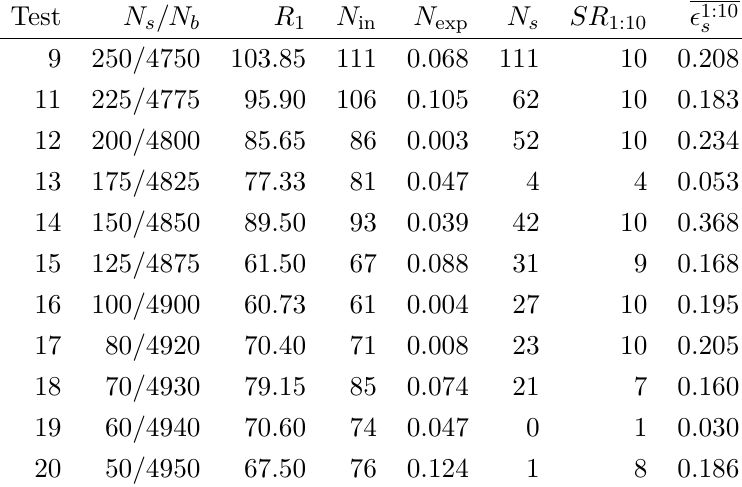
Table 9 . Tests of sensitivity of RanBoxIter to varying signal fraction in MiniBooNE data. All tests use CVR preprocessing of the data samples to remove the 10 most correlated features. See the text for other